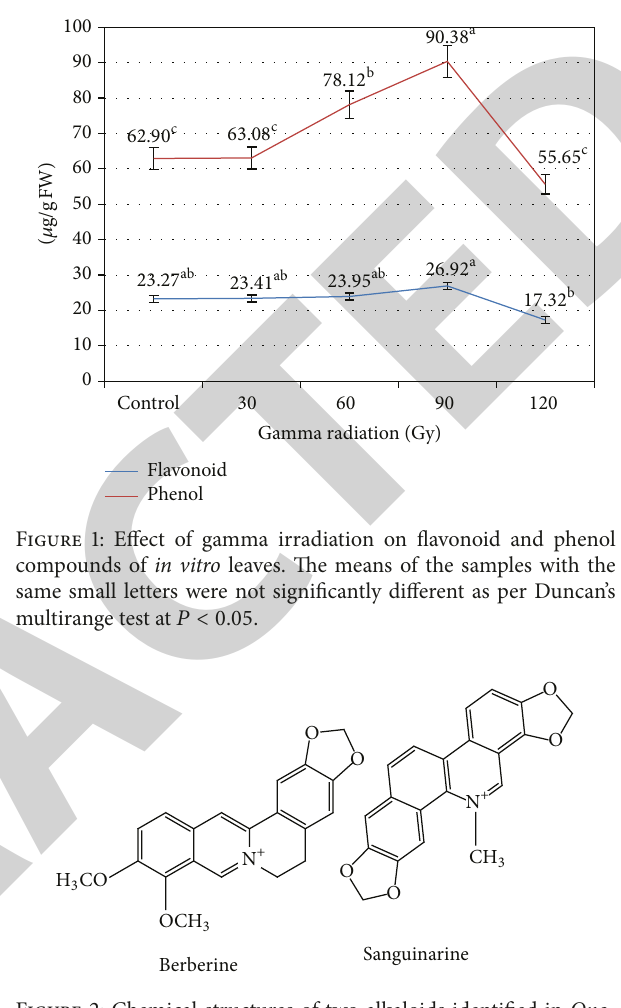
Figure 2: Chemical structures of two alkaloids identified in Ono- brychis viciifolia